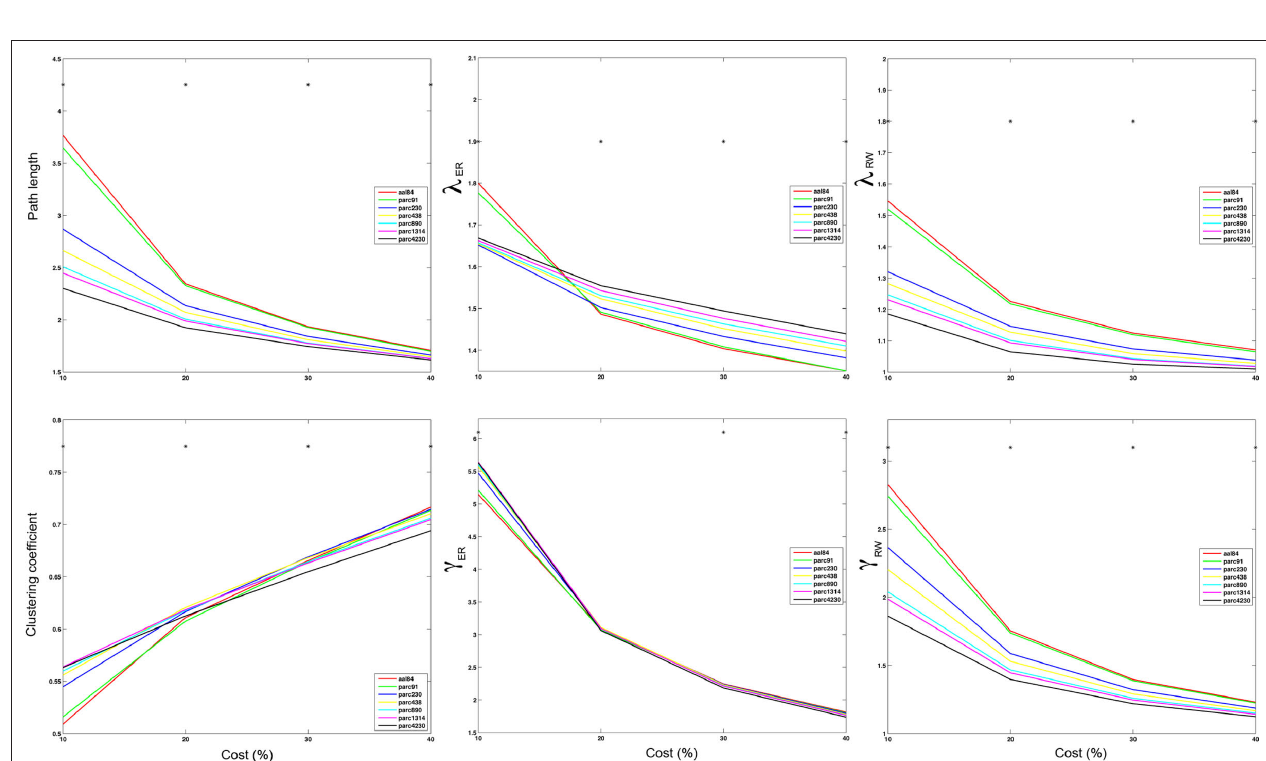
FIguRe 6 | Mean values of global network path length (top left), λ (bottom right) at costs of 10, 20, 30, and 40% for each parcellation scale. * p <